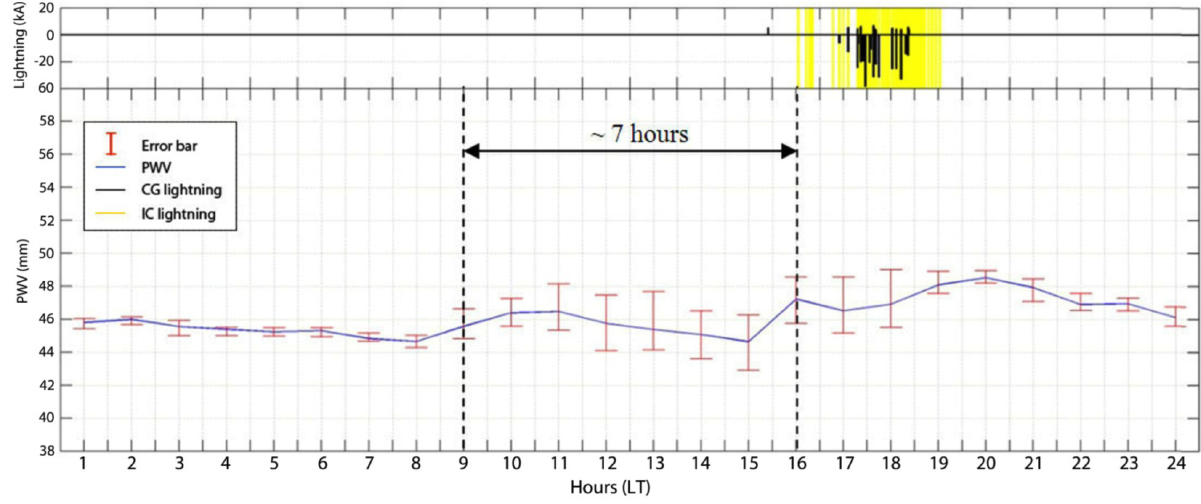
Figure 11. The variation of PWV during heavy lightning on November 7, 2009, for MUAD station, which similar presented as Figure 10.